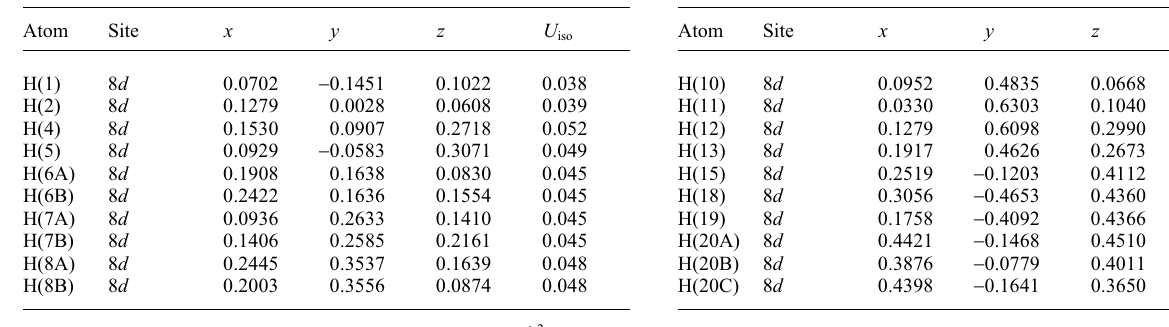
Table 3. Atomic coordinates and displacement parameters (in Å 2 )